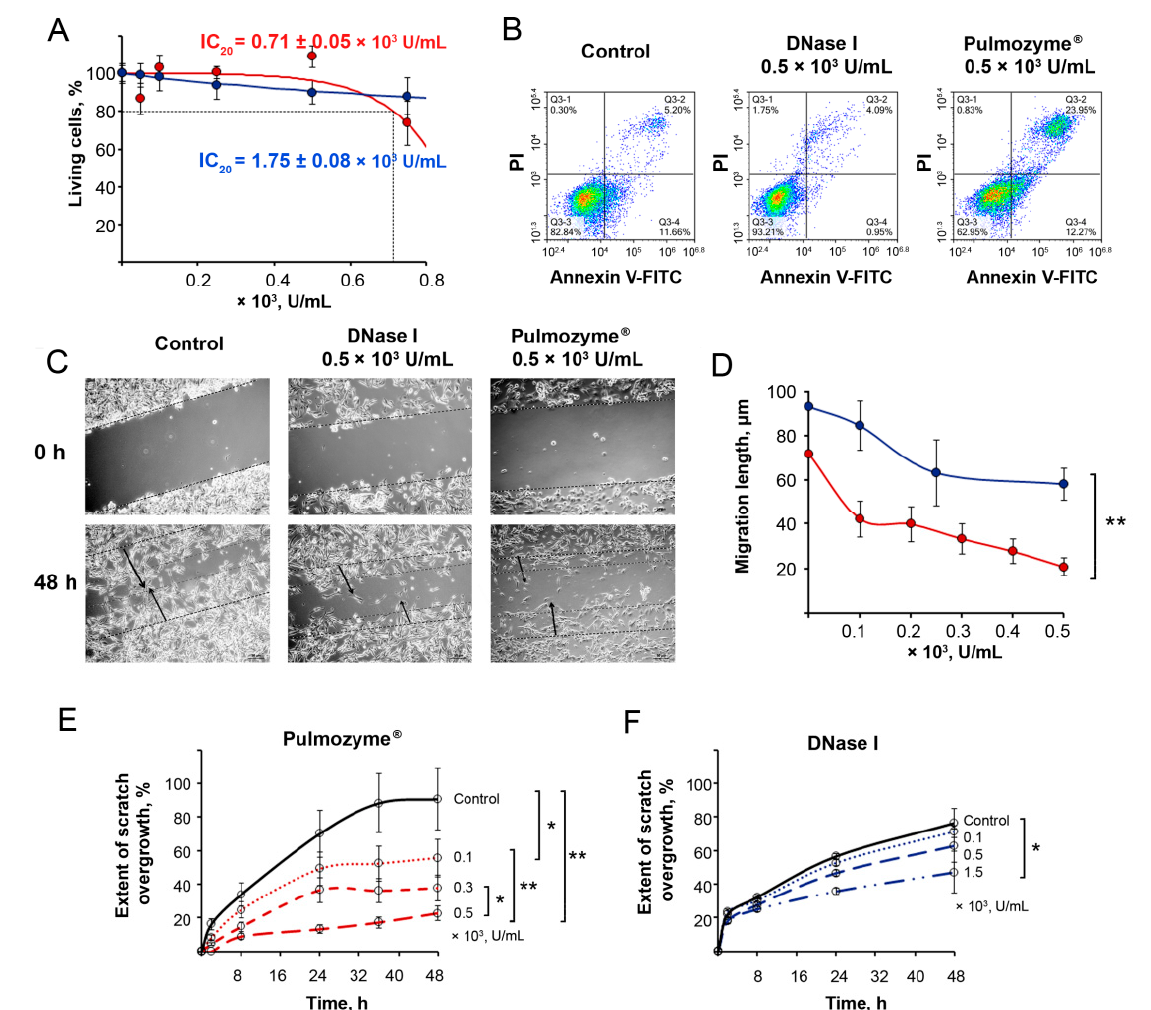
Figure 1. The effect of Pulmozyme ® and DNase I on the viability, apoptosis and migration of melanoma B16 cells. ( A ) Viability of B16 melanoma cells in presence of Pulmozyme ® or DNase I ((0.1–0.75) × 10 3 U/mL) for 48 h. Number of living cells in the control (cells incubated in absence of enzyme) was taken as 100%. Data are presented as mean ± SEM. ( B ) Apoptosis of B16 cells after treatment with Pulmozyme ® and DNase I (0.5 × 10 3 U/mL). Flow cytometry analysis of B16 cells stained with Annexin V-FITC/PI 24 h after treatment is shown. Q3-1, Annexin V-FITC − /PI + , necrosis; Q3-2, Annexin V-FITC + /PI + , late apoptosis; Q3-3, Annexin V-FITC − /PI − cells; Q3-4, Annexin V-FITC + /PI − early apoptosis. ( C ) Photographs of scratch healing by B16 cells incubated with Pulmozyme ® or with DNase I (0.5 × 10 3 U/mL) (4 × magnification). Dotted line shows initial edge of the scratch at time point 0; double dotted lines show boundary of the monolayer at time point 48 h. Arrows show the movement of the migration front. ( D ) Dependencies of migration length of B16 cells on Pulmozyme ® (red) or DNase I (blue) concentration. Data are presented for 48 h of incubation. ( E , F ) Extent of scratch overgrowth of B16 cells incubated with various concentrations of Pulmozyme ® ( D ) or DNase I ( E ). Migration of intact cells (control)—black curve. * and **—statistically significant differences with p < 0.05 and p < 0.01.